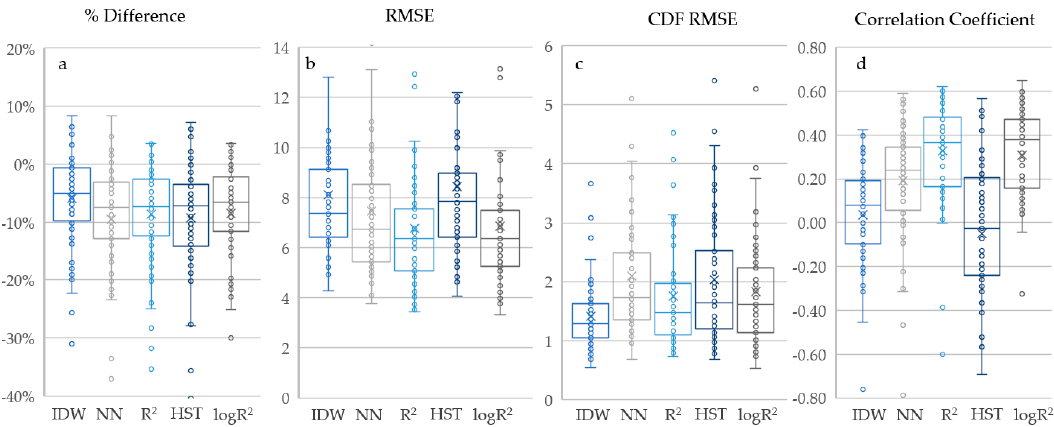
Figure 5. Results of the comparison between the filled-in data using different methods and the validation data, after the quantile mapping correction. In ( a ), the % difference in the mean is shown, in ( b ) the RMSE, ( c ) CDF RMSE and ( d ) Pearson’s r. Different colors serve only for artistic purposes.